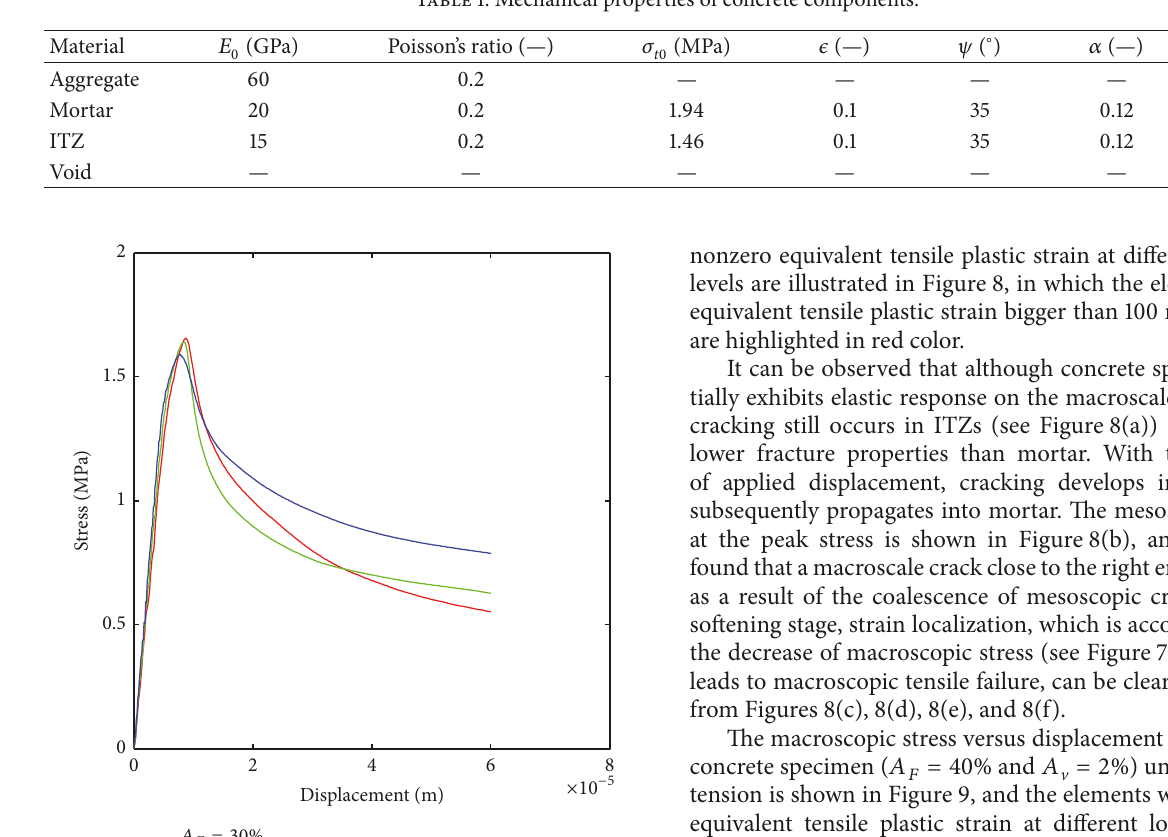
Table 1: Mechanical properties of concrete components.